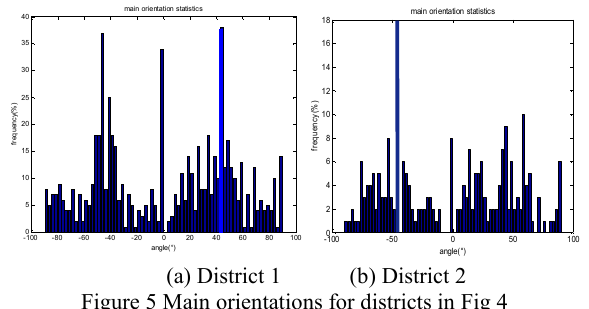
Figure 5 Main orientations for districts in Fig